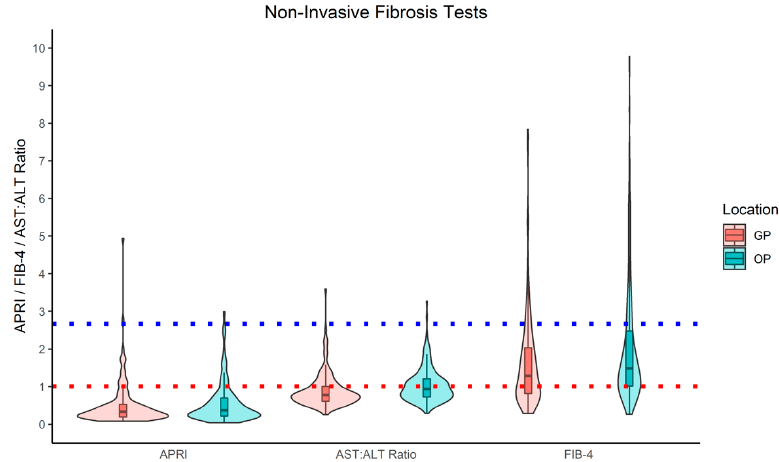
Figure 2. Summary Graphs of FIB-4, APRI, AST:ALT Ratio by Test Location. Red dotted line = cut-off for high-risk fibrosis via APRI and AST:ALT Ration. Blue dotted line = cut-off for high risk liver fibrosis via FIB-4, FIB-4 = Fibrosis 4, APRI = AST to Platelet Ratio Index, n = Number, GP = General Practice, OP = Outpatient.